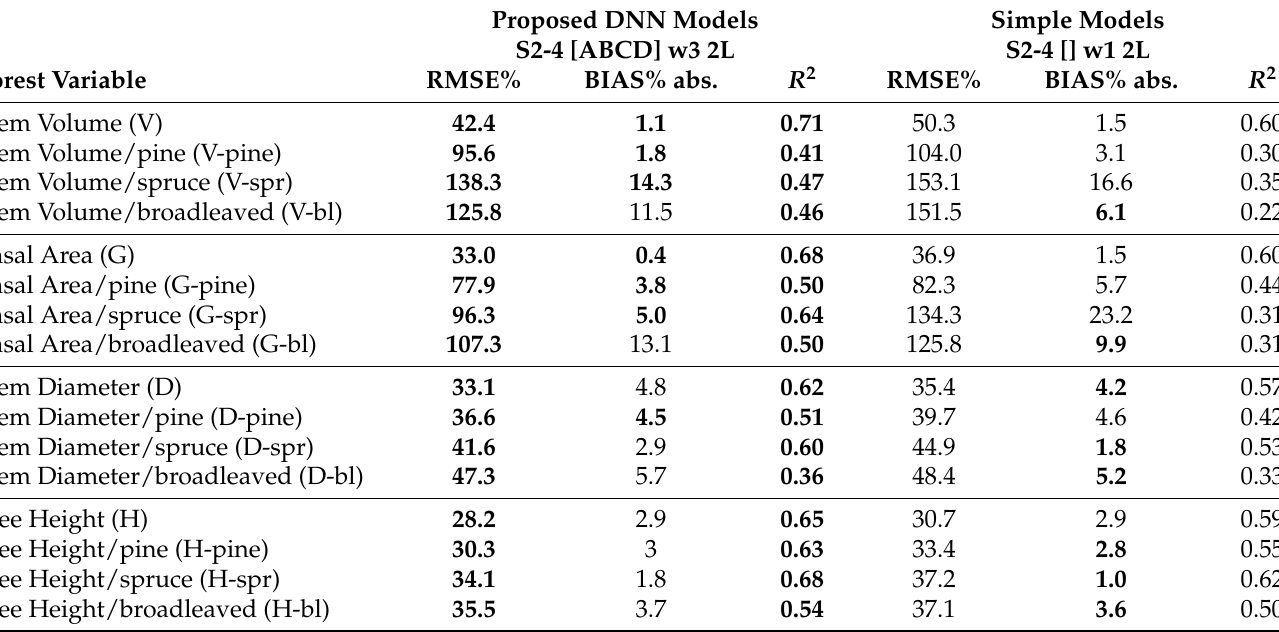
Table 8. Test set relative root-mean-square error (RMSE%), average of relative bias absolute values (BIAS% abs.), and coefficient of determination ( R 2 ) for forest variables stem volume (V), basal area (G), stem diameter (D), and tree height (H), and their species-specific components (suffixes -pine for pine, -spr for spruce, and -bl for broadleaved). The proposed DNN models with two hidden layers using [ABCD] input variables and 3 × 3 window image sampling compared to models using pixel-wise S2 image data and two hidden layers. The best performance values in